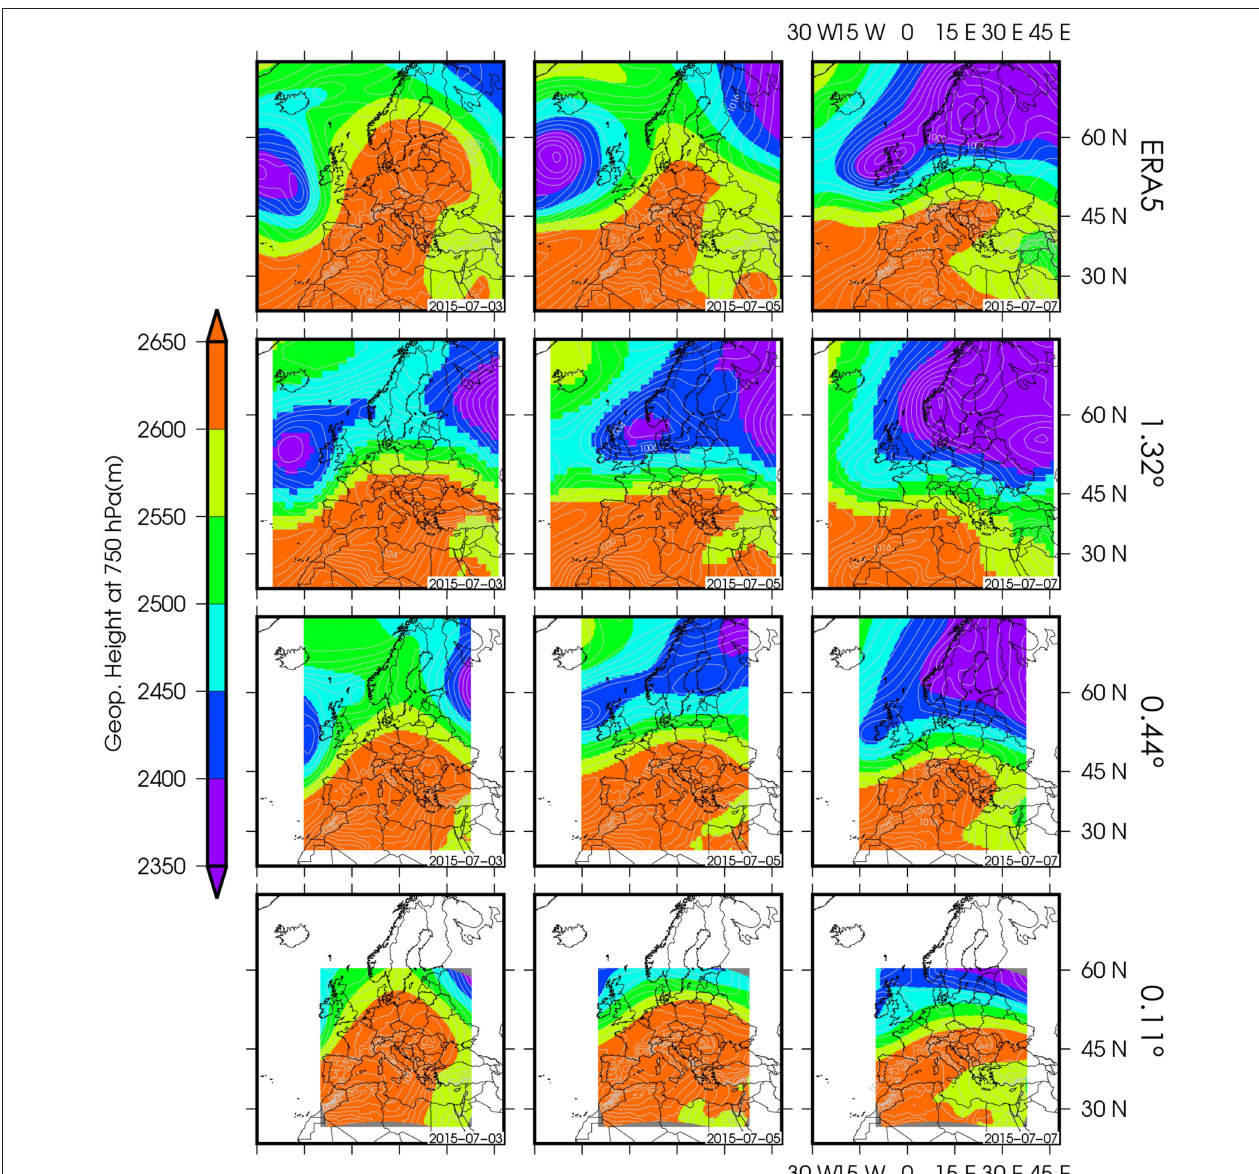
FIGURE 6 | Synoptic situation of Saharan desert dust outbreak. Selected days are 3rd, 5th, 7th July (left, center, and right, respectively). ERA5 at the top row and each resolution from the second (1.32 ◦ ) to the bottom (0.11 ◦ ). Colors display geopotential height in m at 750 hPa and gray lines, the sea level pressure (SLP) in